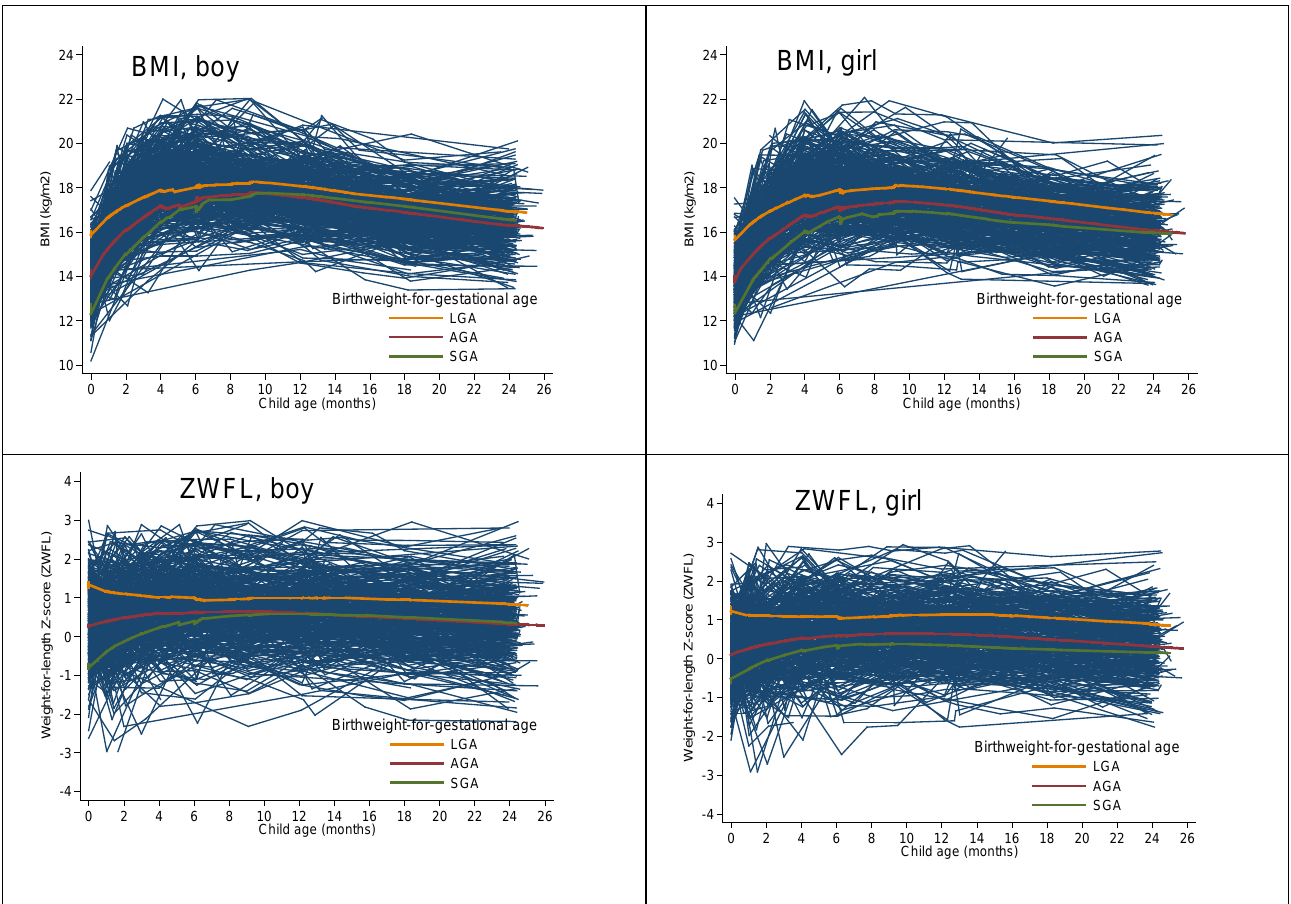
Figure 1. Spaghetti plot of 6340 longitudinal anthropometric adiposity measures from age 0–25 months and LOWESS regression plot by AGA, SGA, and LGA status in 806 term-born children (418 boys and 388 girls). AGA: appropriate for gestational age; SGA: small for gestational age; LGA: large for gestational age.